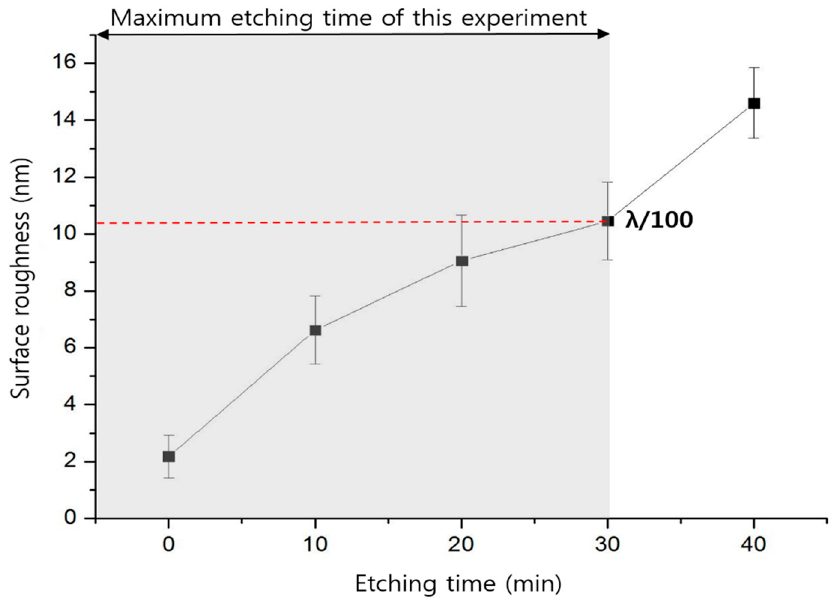
Figure 6. Effect of etching time on the surface roughness of the glass substrate (fused silica) (5 sections, the size of the examined area is 30 × 30 μ m 2 ).